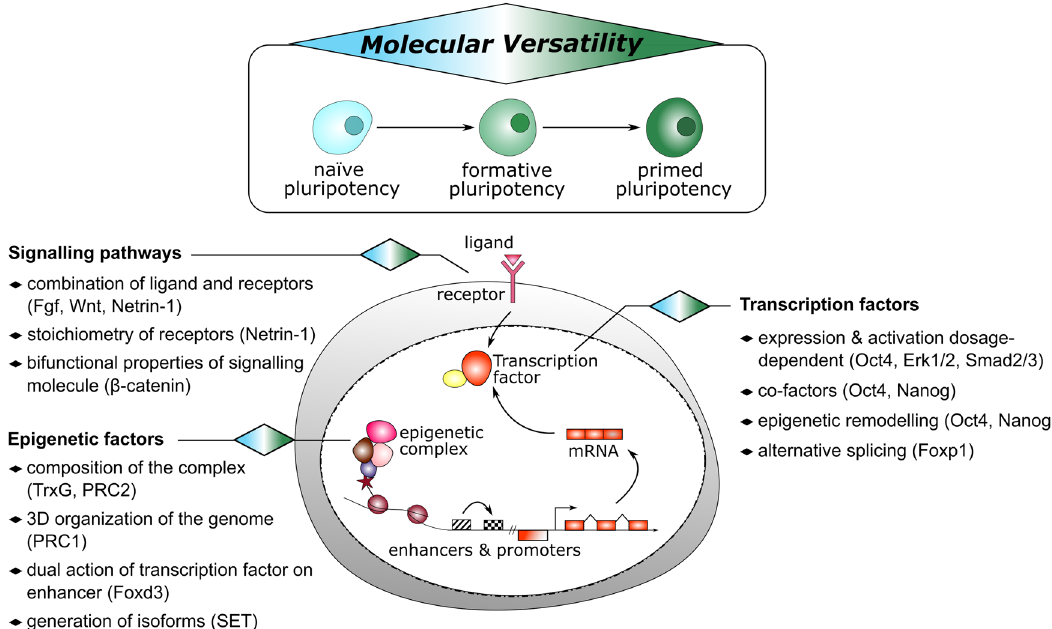
Fig. 5 | Molecular Versatility during pluripotency progression. The scheme summarises the different mechanisms highlighted in the Perspective to allow